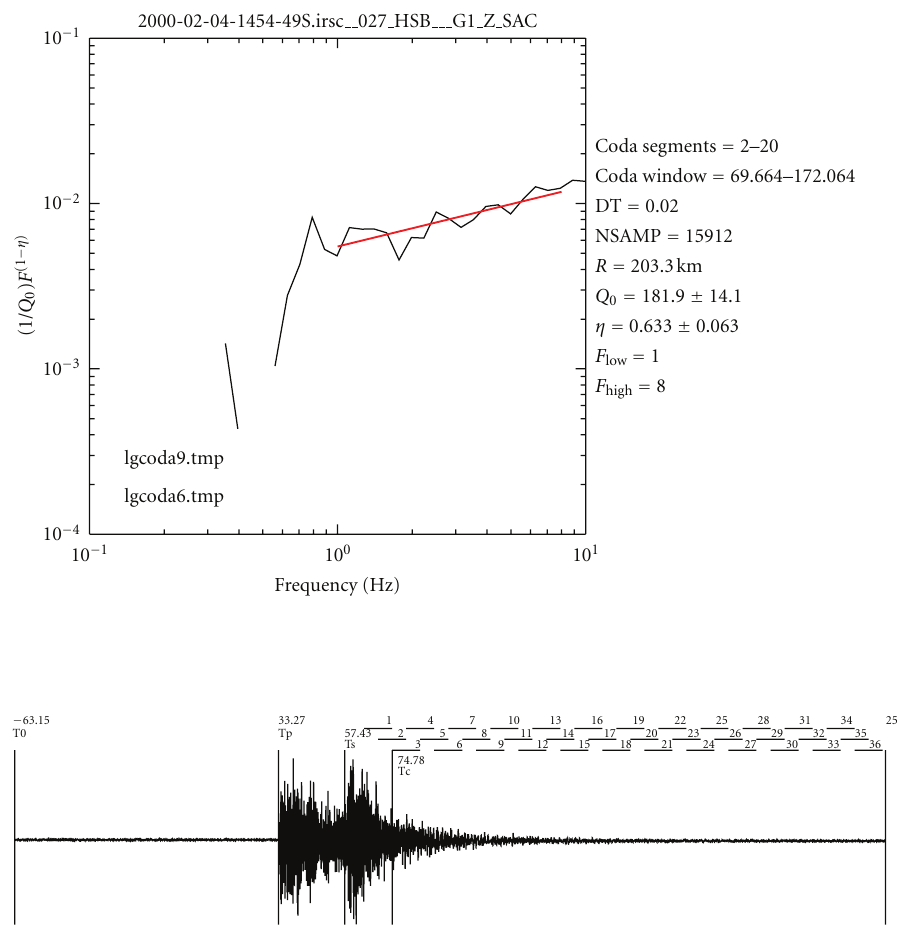
Figure 3: Logarithmic (1 /Q 0 ) F 1 − η versus frequency diagram for earthquakes with epicentral distance of 203 km. Windows are shown on the waveform. Average Q 0 and η are estimated using a linear regression (solid line). The y -intercept of this line gives the quality factor Q 0 . Estimated errors are also indicated in the corresponding frequency